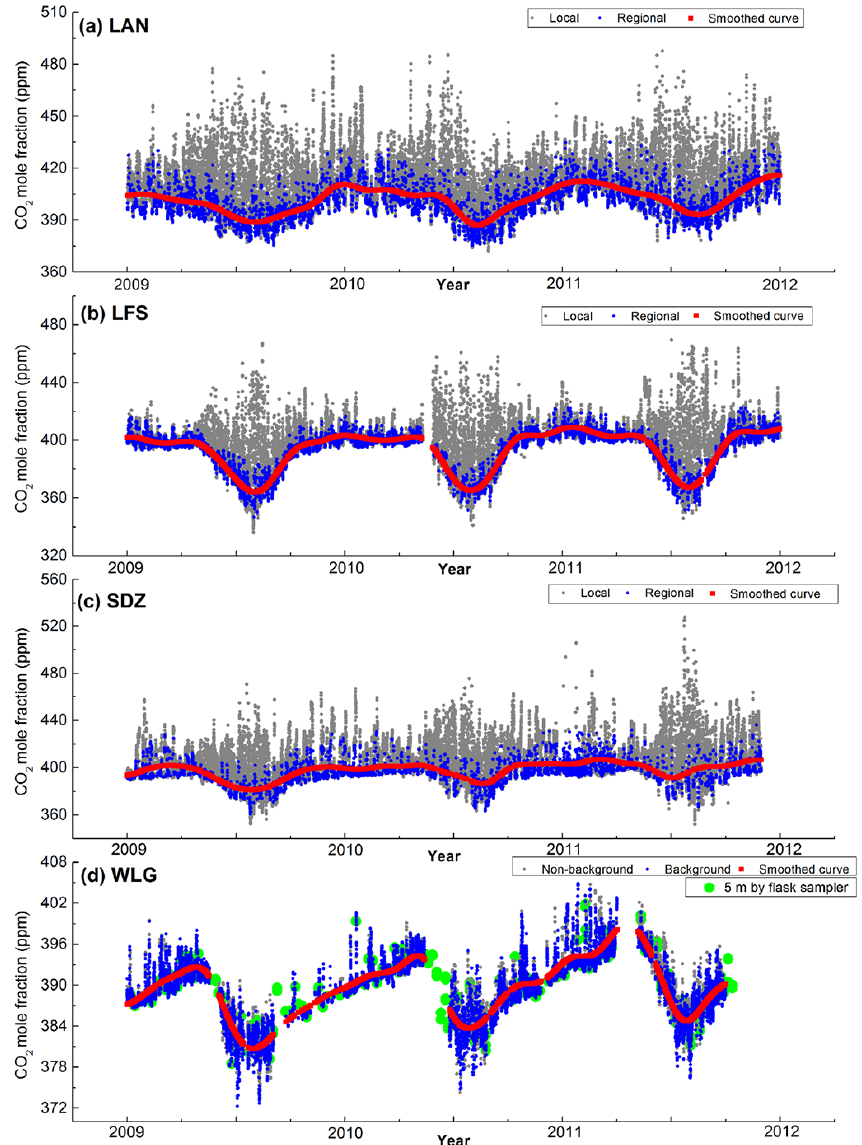
Fig. 2. Seasonal variations of hourly CO 2 mole fractions at (a) Lin’an (LAN), (b) Longfengshan (LFS), (c) Shangdianzi (SDZ), and (d) Mt. Waliguan (WLG). Grey dots are locally representative CO 2 mole fractions and the blue dots are regional or background records. See Sect. 3.5 for further details. The red dots are curve-fitted results to the regional records using the curve-fitting method by Thoning et al. (1989). The concentrations at LAN, LFS, and SDZ are from 10ma.g.l. At WLG (d) , grey and blue dots are CO 2 concentration from 80ma.g.l., and green dots denote discrete CO 2 flask pair measurement from the NOAA ESRL flask air-sampling